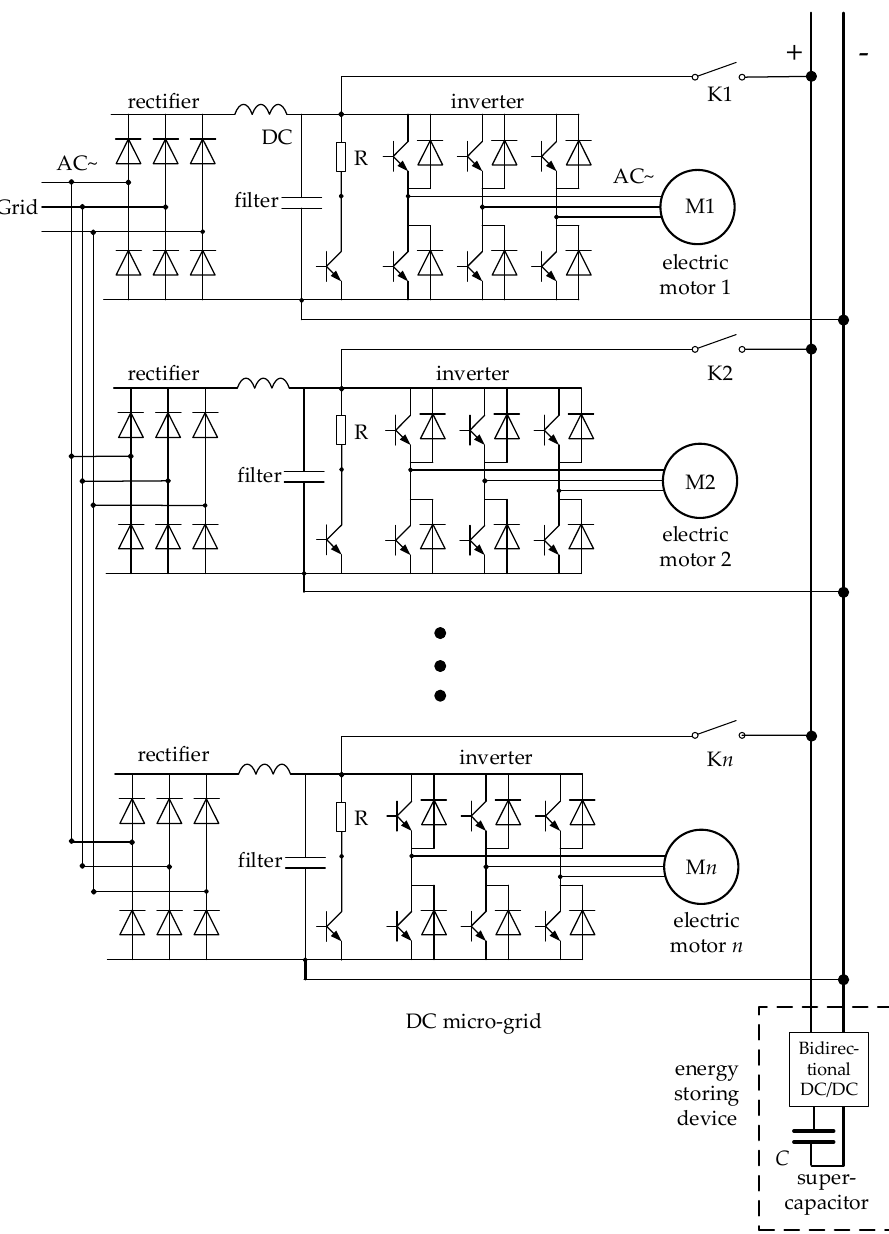
Figure 2. Elevator DC micro-grid power dispatching energy-efficient method